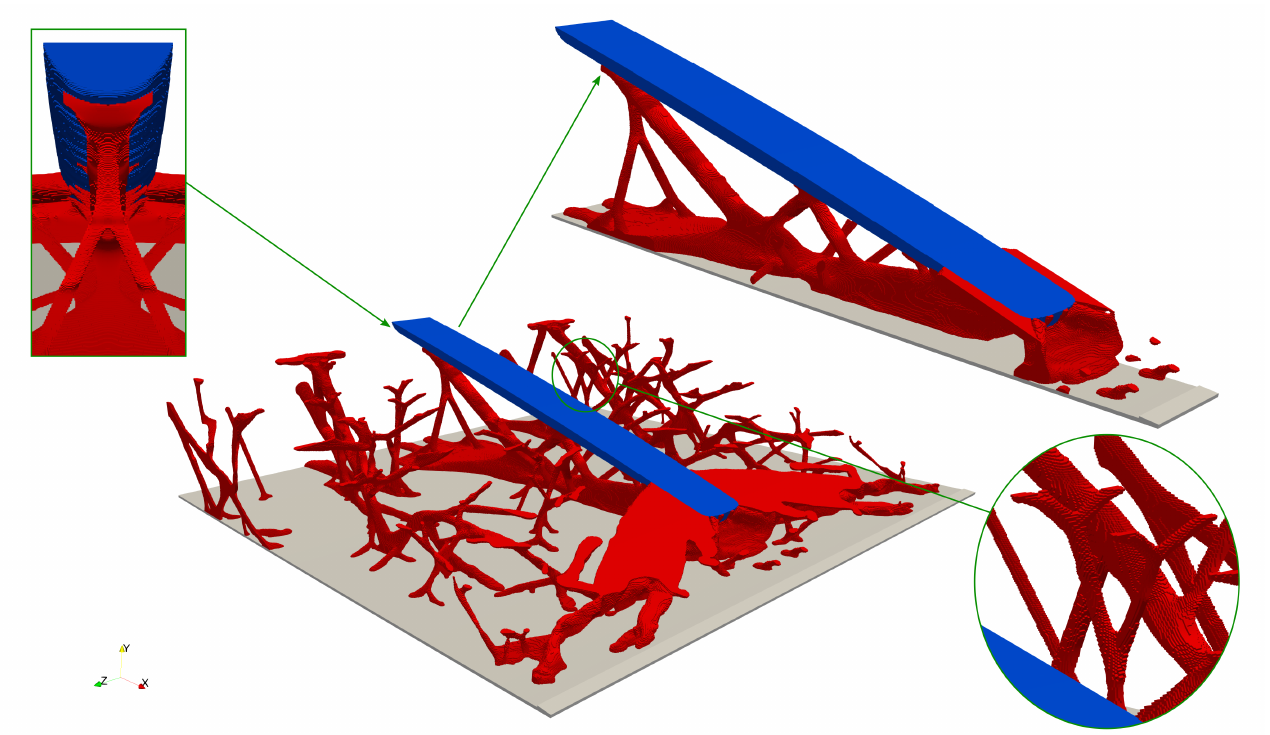
Figure 10. Isometric view of the resulting topology from the feature-mapping approach. The skin on the top side is removed for viewing the internal structure. The field is realized with a threshold value of 0.5. The top-left close-up shows how the structural material is well connected to the actuation material. In the top-right corner, the actuator is isolated; notice how a compliant mechanism is formed under the actuator. The bottom-right close-up shows how a hierarchical branching structure is forming.